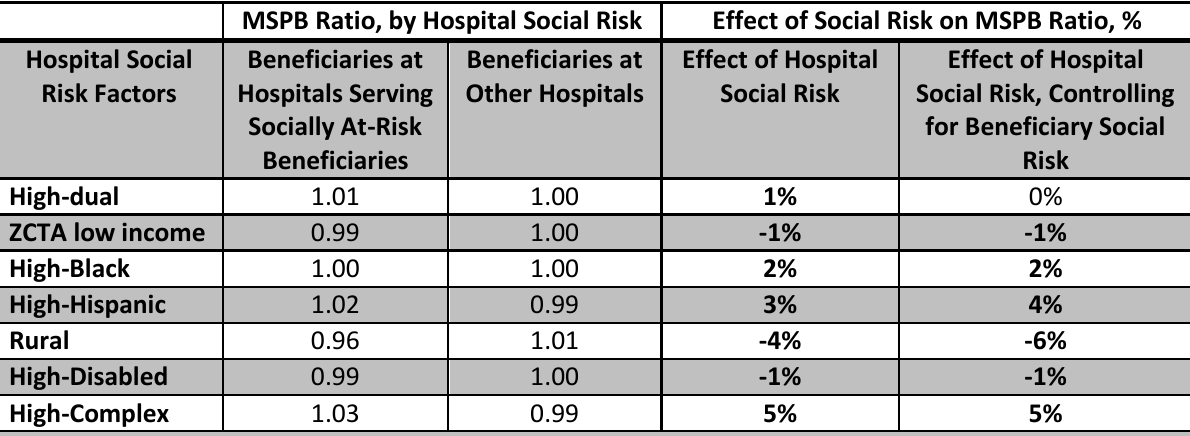
Table 7.5. Relationship Between Hospital Social Risk or Medical Complexity and MSPB